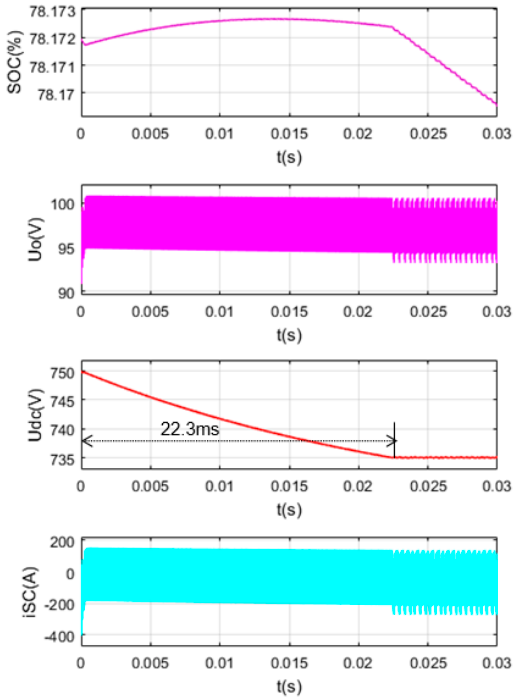
Figure 14. Simulation waveform diagram of the MPC for the DAB-SC system when the initial voltage, U dc , is 749.7 V and the initial voltage, u o , is 98.1 V.